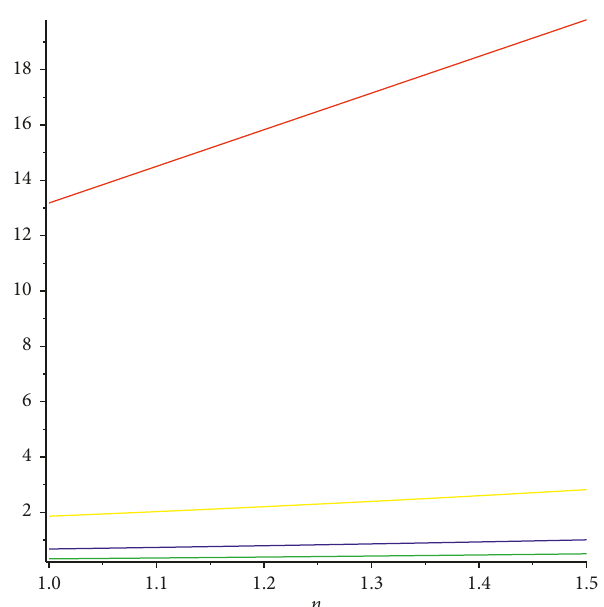
Figure 20: IRGA of D